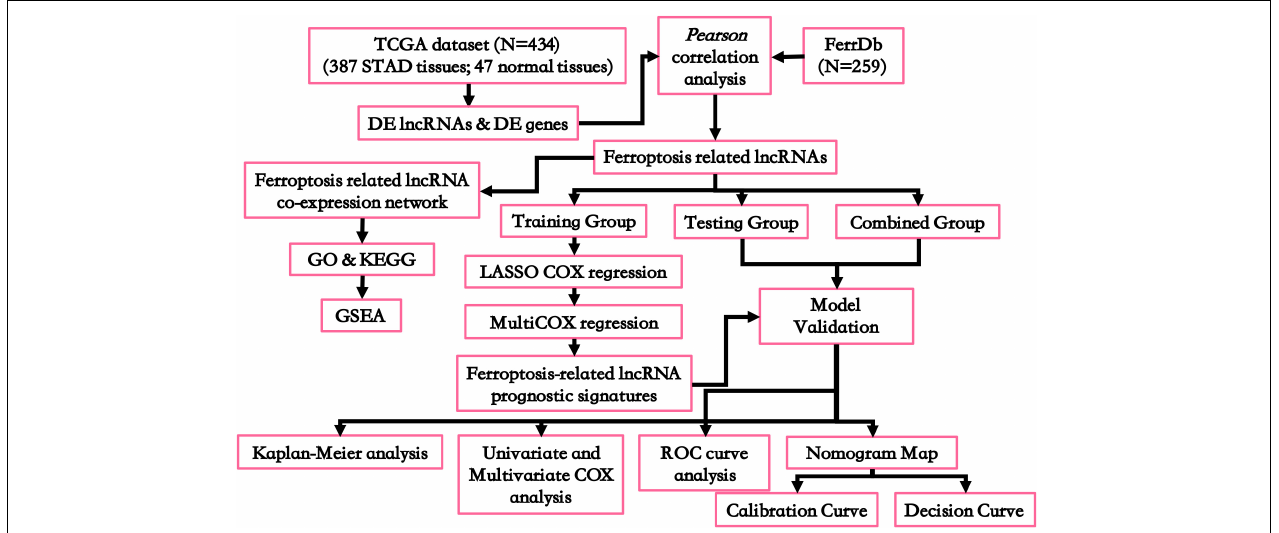
FIGURE 1 | Flowchart for this work. DE, differentially expressed; GO, Gene Oncology; KEGG, Kyoto Encyclopedia of Genes and Genomes; GSEA, gene set enrichment analysis; ROC curve, receiver operating characteristic curve.